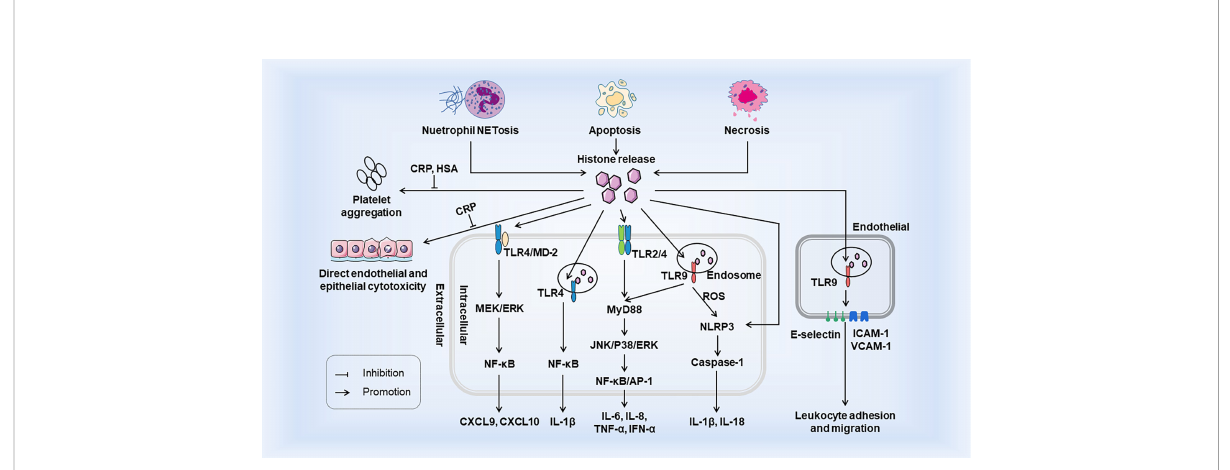
FIGURE 1 Histones release and its immunostimulatory effects as DAMPs. Histones are released from tissue cells by NETosis, apoptosis, and necrosis. Extracellular histones bind to TLR to trigger intracellular MyD88-dependent signaling pathways and promote the release of cytokines and chemokines, which trigger in fl ammatory responses and the recruitment and migration of immune cells. Activation of TLR9 leads to the release of ROS, which activates the NLRP3 in fl ammasome, Caspase1, and further immune cell recruitment. Extracellular histones also induce the surface expression of three endothelial adhesion molecules (E-selectin, ICAM-1 and VCAM-1) through TLR9, thereby facilitating promoting leukemia cell adhesion and migration. Extracellular histones induce endothelial and epithelial cell damage and platelet aggregation, but both are inhibited by CRP. In addition, HSA also inhibits histone - induced platelet aggregation. Both CRP and HSA protect the body from the toxicity of histones released into circulation. HSA, Human Serum Albumin; CRP, C-reactive